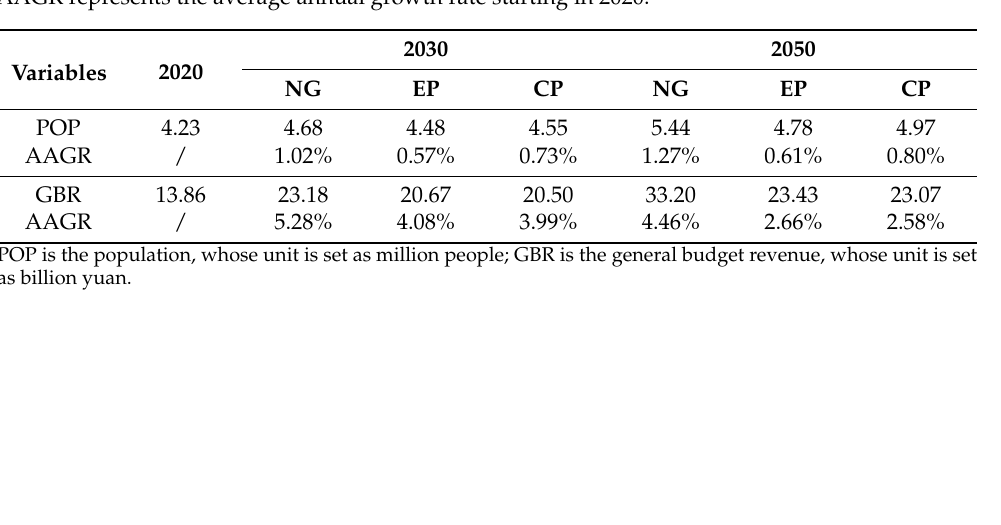
Table 4. The total POP and GBR in the Jinjiang Basin under the three scenarios from 2020 to 2050. AAGR represents the average annual growth rate starting in 2020.